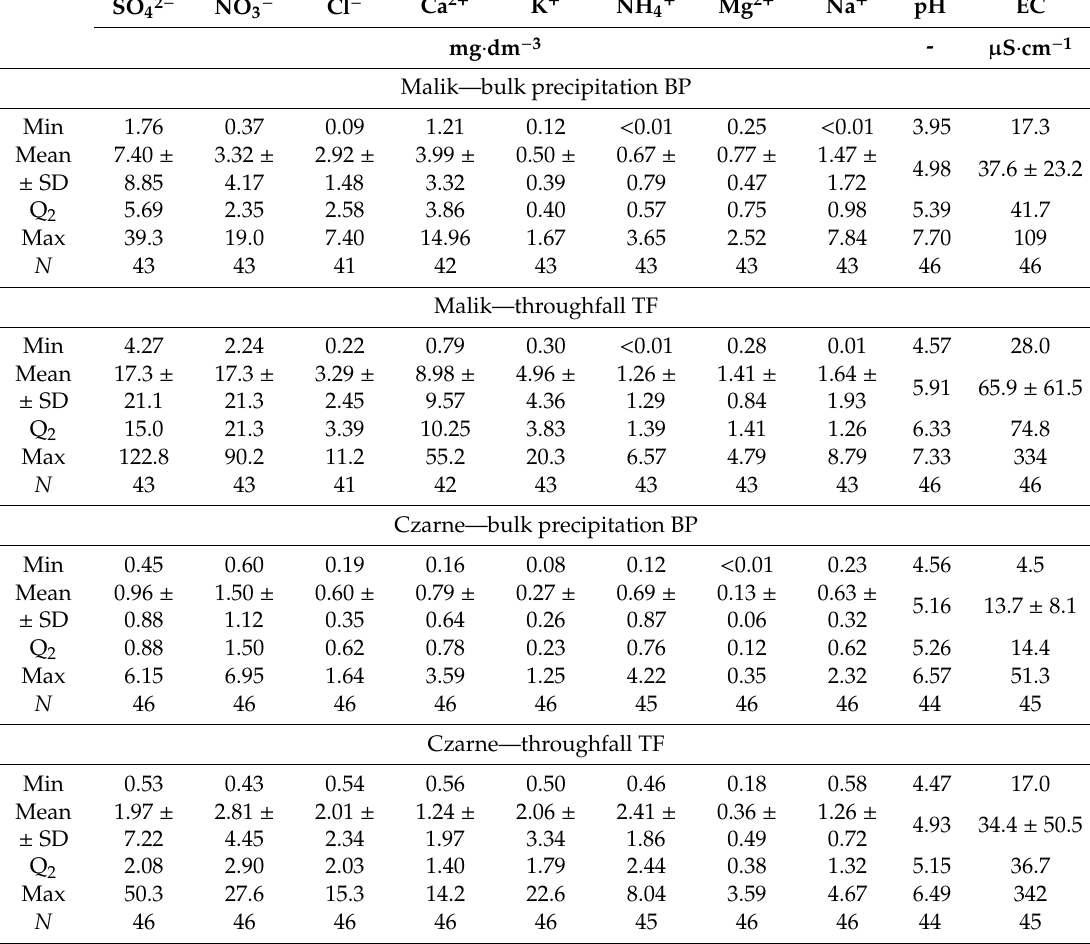
Statistical descriptors of the chemical composition of bulk precipitation (BP) and throughfall